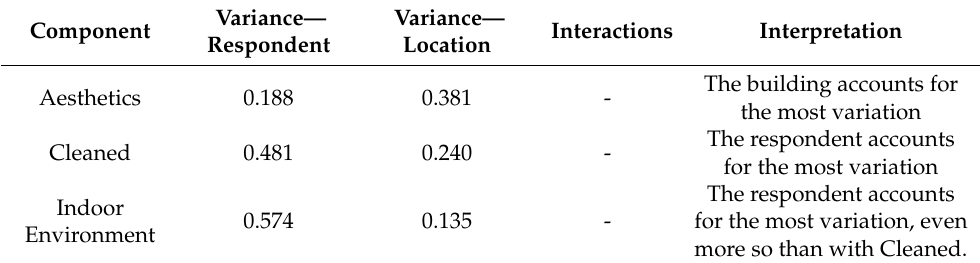
Table 15. Locations—The two random factors in the mixed linear regressions. Variance— Variance— Component Interactions Respondent Location